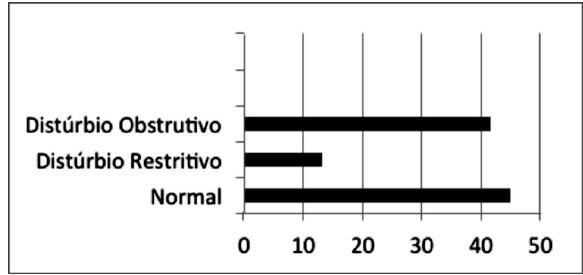
2 - Proportion of respiratory disturbance classification by spirometry in elderly with PD attended at CREASI in Salvador/BA,